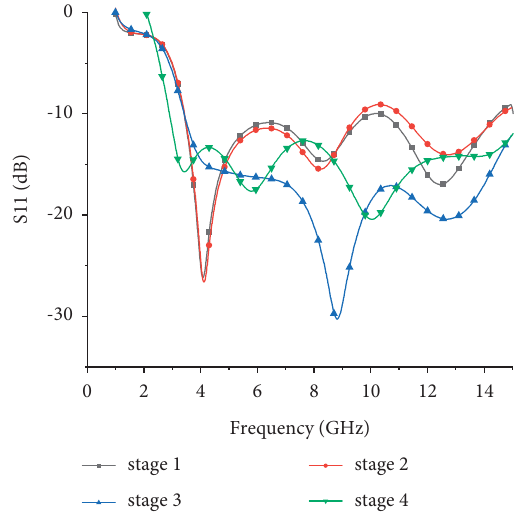
Figure 5: Simulated reflection coefficient of the evolution of the antenna.